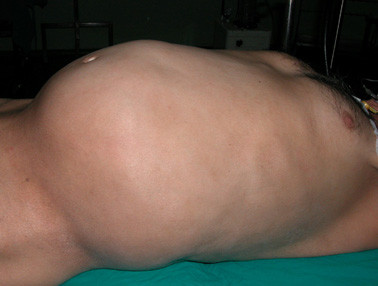
Preoperative appearance of the patient showing abdominal distention.